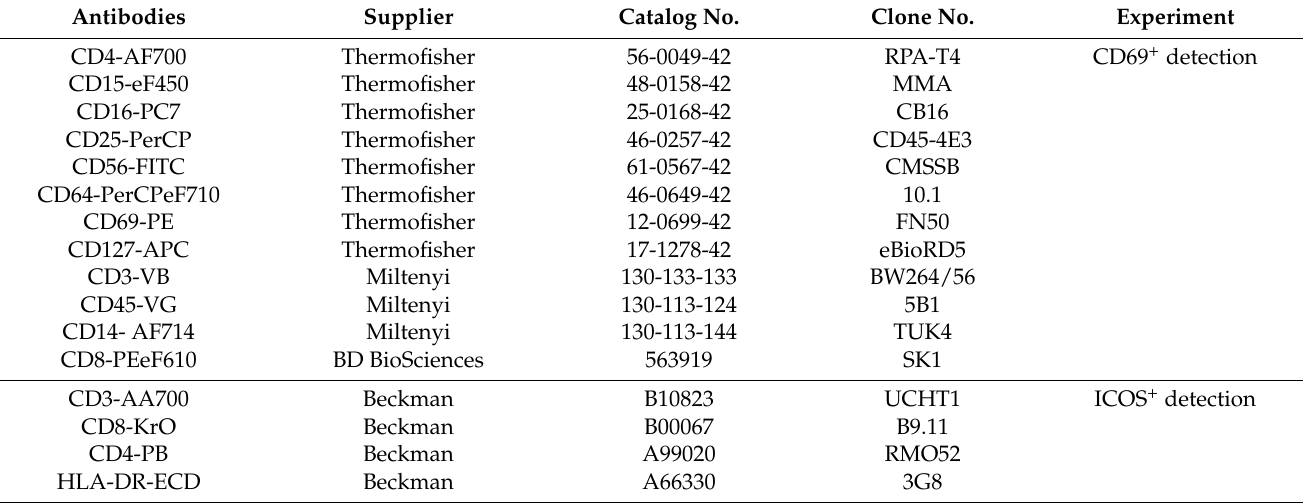
Table 1. Flow cytometry antibodies used. Antibodies Supplier Catalog No. Clone No.